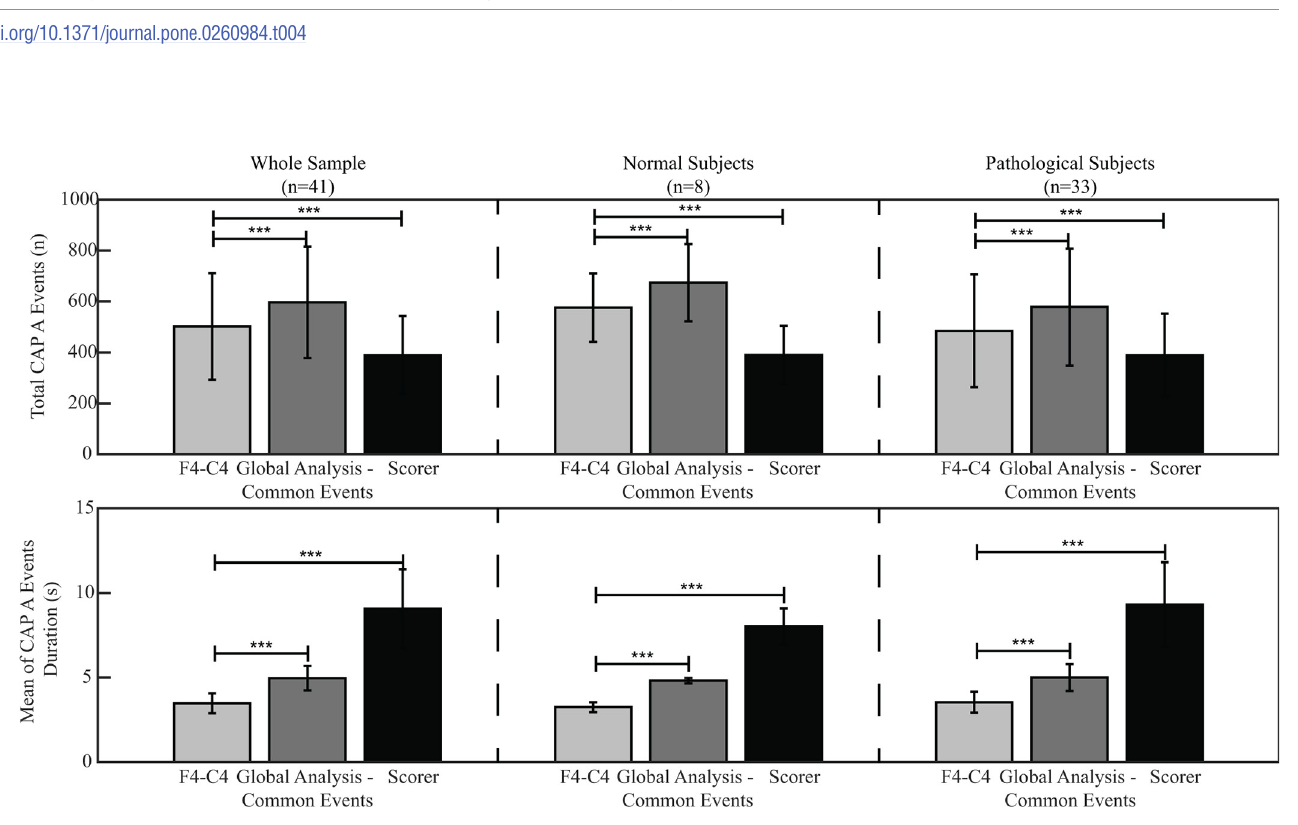
Fig 3. Graphic representation of the total CAP A with their mean duration detected by the algorithms (F4-C4 and global analysis–common events) and by the scorer in the whole sample, as well as in the normal and pathological subjects. Paired t-test was used for the comparisons. Asterisks indicate significant differences ( � , p � 0.05; �� , p � 0.01; ��� , p �